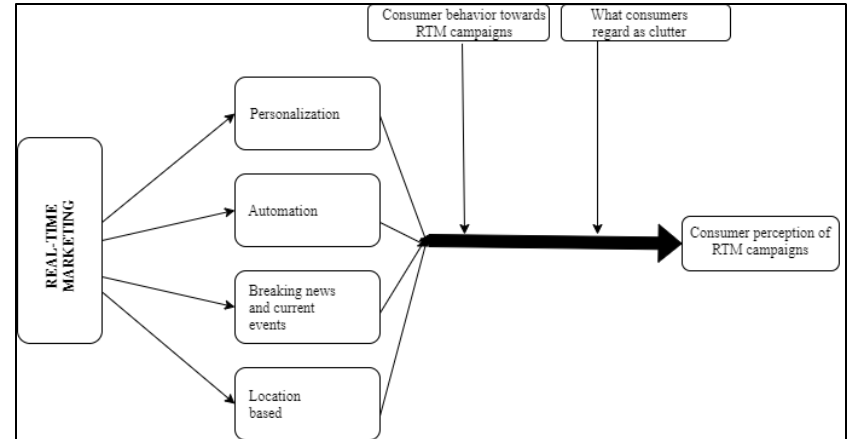
Figure 1: Theoretical